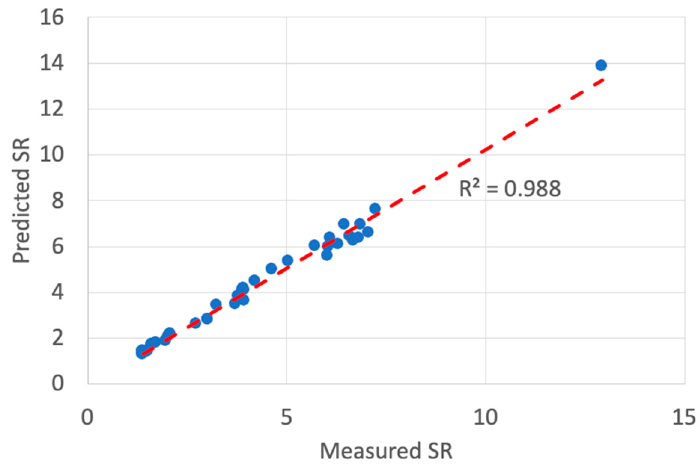
Figure 13. Coefficient of determination of ANFIS-QPSO prediction results for the cryogenic turning process.